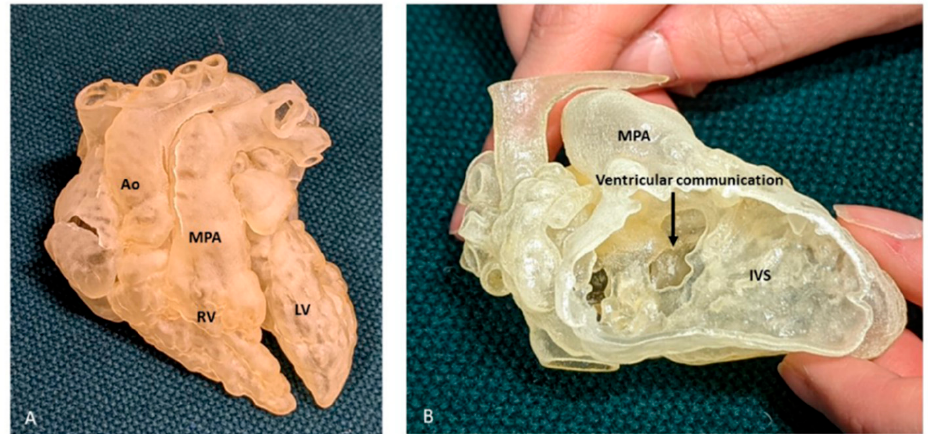
Figure 10. Three-dimensional printed model from a case of DORV. ( A ) View of the anterior surface of the heart, demonstrating the relation of the great arteries, both committed to RV. ( B ) Right ventricular view of interventricular communication, looking at the IVS “en face”. The rims of the defect can be appreciated, but there is paucity of any additional intracardiac details, especially with regard to TV. Ao: Aorta; LV: Left ventricle; MPA: Main pulmonary artery; RV: Right ventricle.